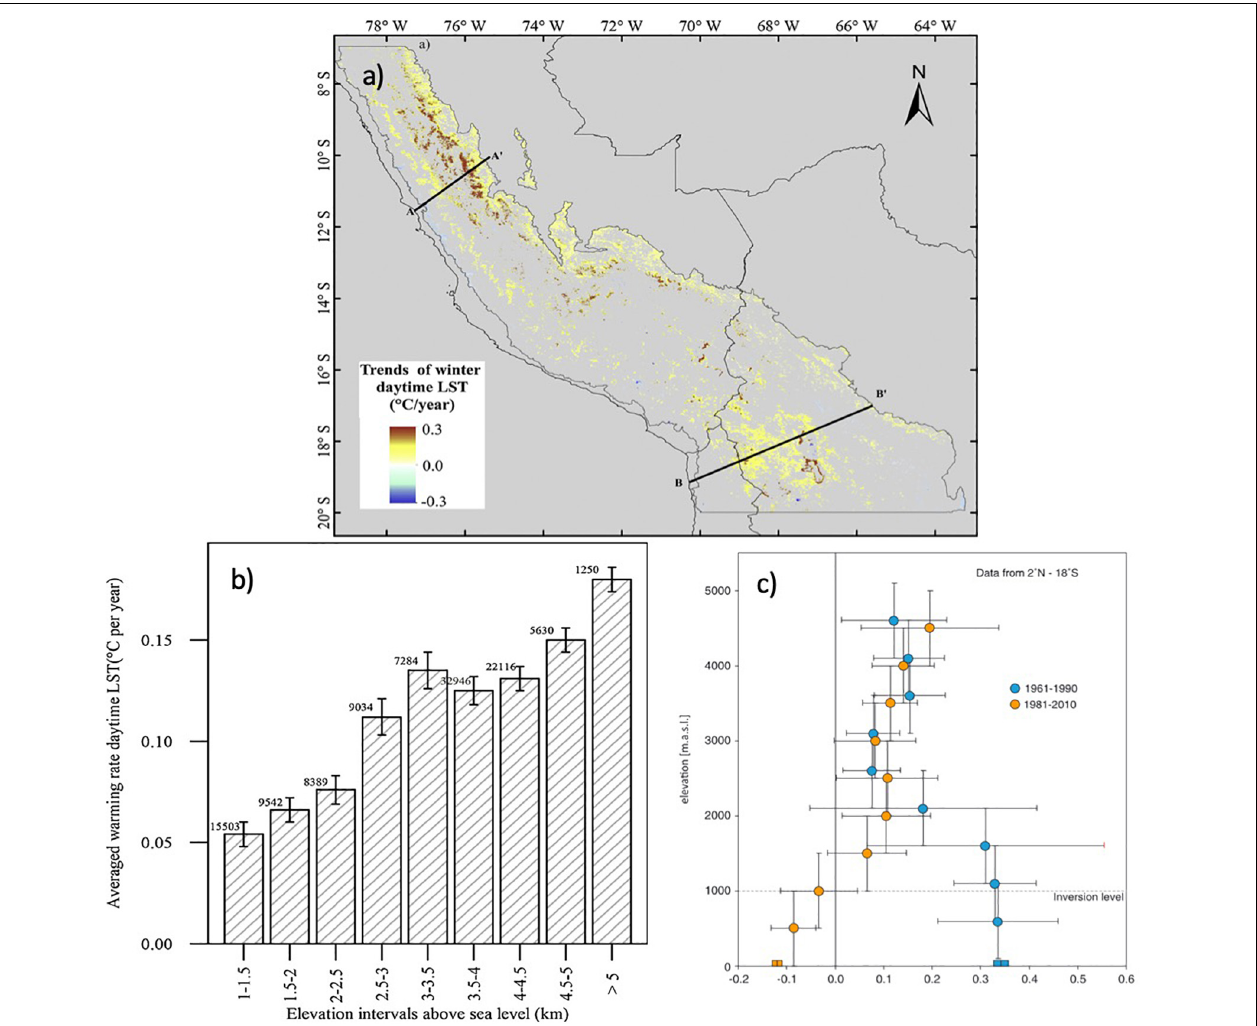
FIGURE 2 | (a) Spatial distribution of the daytime land surface temperature (LST; ◦ C/year) trend in austral winter [June-July-August (JJA)] over the Andes between 7 ◦ S and 20 ◦ S for the period 2000–2017 (MODIS LST Data). Trends are significant at 95% ( p = 0.05) confidence level. (b) Averages of winter daytime LST trends at 500-m intervals in the tropical Andes (7 ◦ S–20 ◦ S). Values at the top of bars indicate the number of MODIS pixels at each elevation range. (a,b) Are adapted from Aguilar-Lome et al. (2019). © International Journal of Applied Earth Observation and Geoinformation. Reprinted by permission from Elsevier. (c) Air temperature trends versus altitude along the western tropical Andean slopes (2 ◦ N–18 ◦ S) for the periods 1961–1990 (blue circle) and 1981–2010 (orange circle). Adapted from Vuille et al. (2015). © American Geophysical Union. Reprinted by permission from John Wiley and